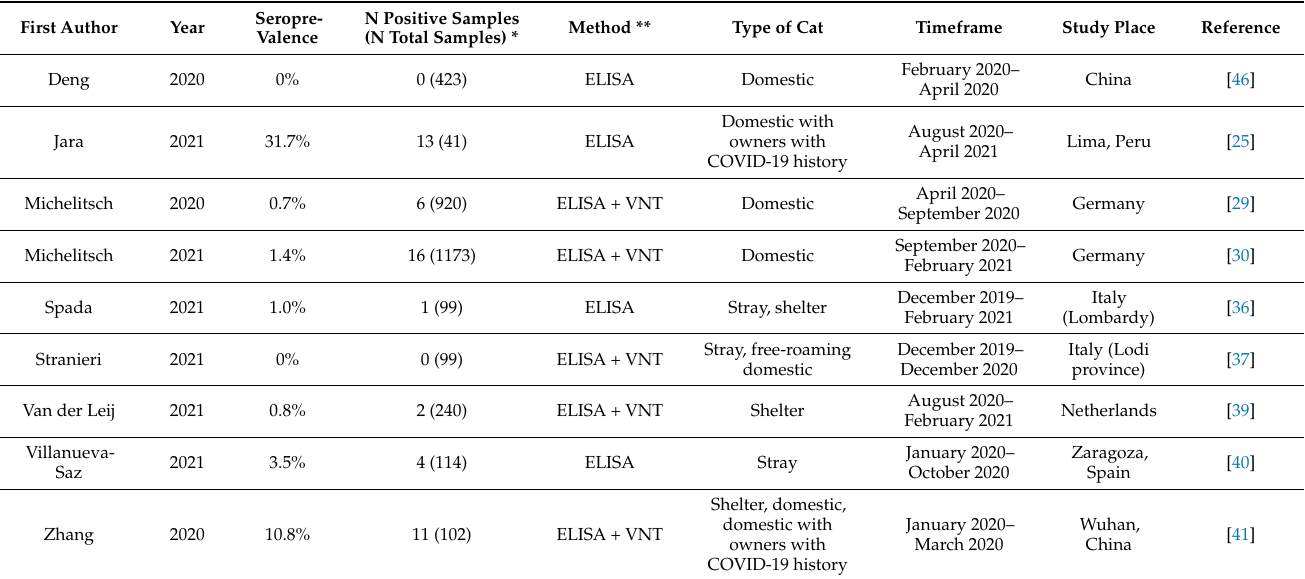
Table 3. Cross-sectional studies investigating seroprevalence of SARS-CoV-2